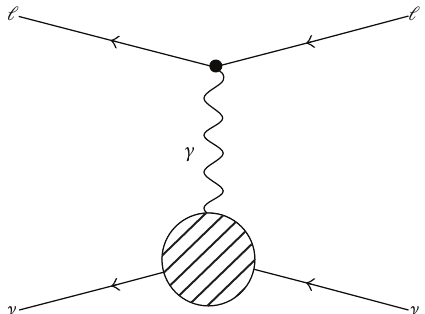
Figure 2: Contribution of the neutrino electromagnetic vertex function to neutrino elastic scattering on a charged lepton